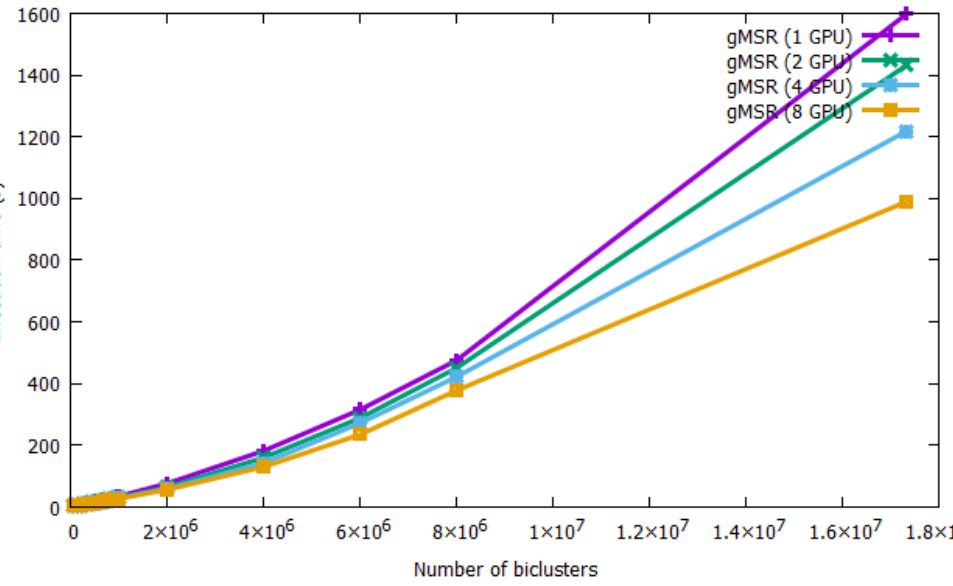
Figure 6. The performance of single-GPU and multi-GPU mode of gMSR is presented. The graph shows that gMSR is capable of processing large datasets with a very good performance. Additionally,